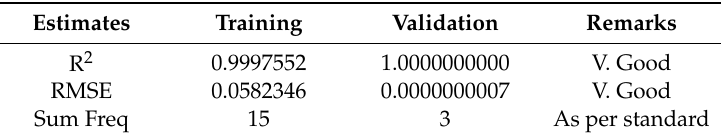
Table 6. Model Strength Evaluation of Training and Validation Data.